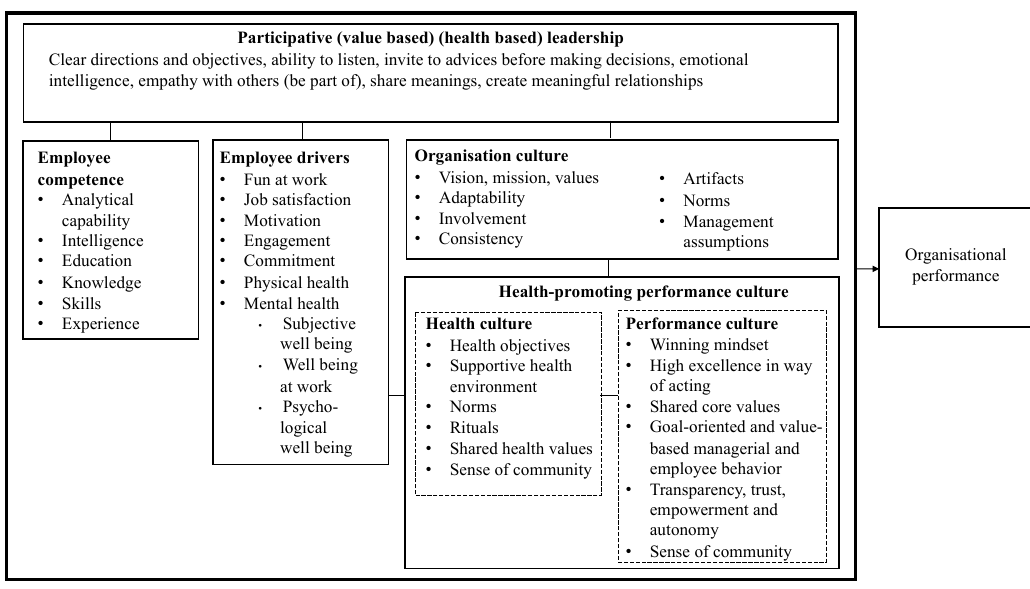
Figure 1. A health-promoting performance culture and individual HR drivers of organisational Figure1. performance.